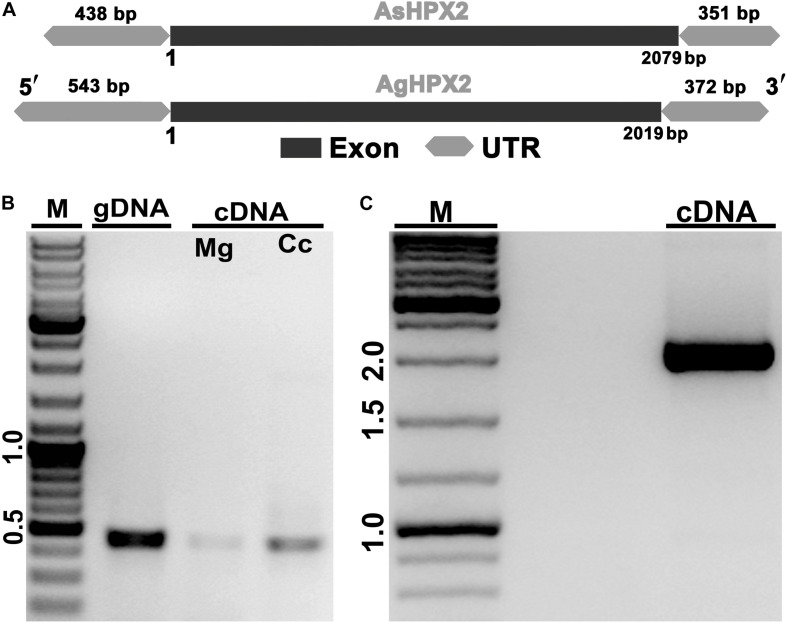
Molecular identification of AsHPX2 gene. (A) Genomic organization of AsHPX2 gene: both AgHPX2 (2,019 bp) and AsHPX2 (2,079 bp) genes have single exon. The 5′ and 3′ UTRs of AsHPX2 gene are 438 and 351 bp, respectively. However, 5′ and 3′ UTRs of AgHPX2 gene are 543 and 372 bp, respectively. (B) PCR amplification of 450 bp partial segment of AsHPX2 gene using F1R1 primers from genomic DNA (gDNA), midgut (Mg) or carcass (Cc) cDNA template. (C) PCR amplification of full-length AsHPX2 gene from cDNA template using F4R5 primers. M represents the DNA ladder in kb.